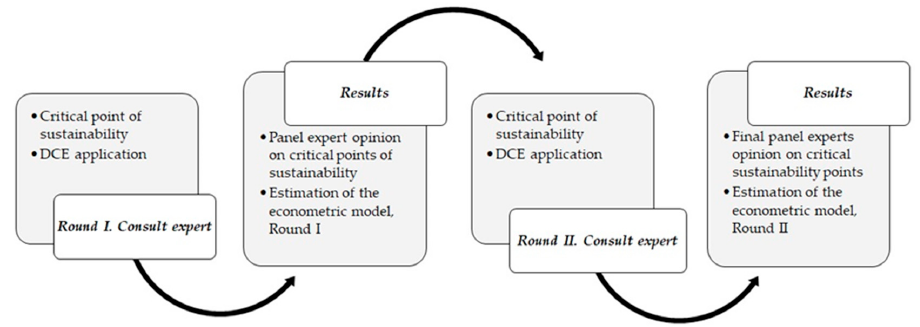
Figure 2. Sampling process following the Delphi method applied in this study.